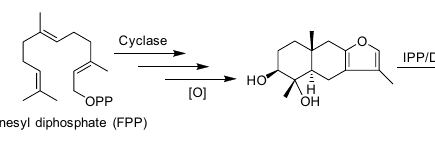
Fig. 1 Structures of compounds 1 – 5